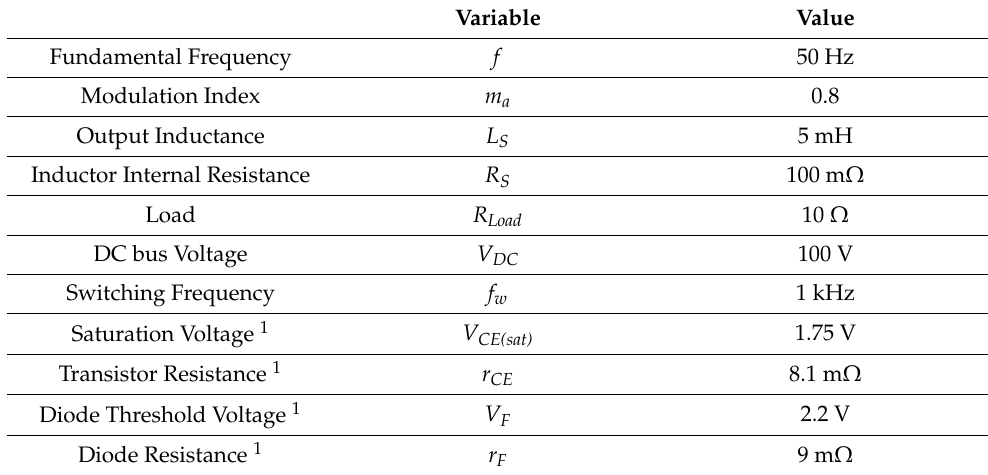
Table 4. Main simulation parameters.